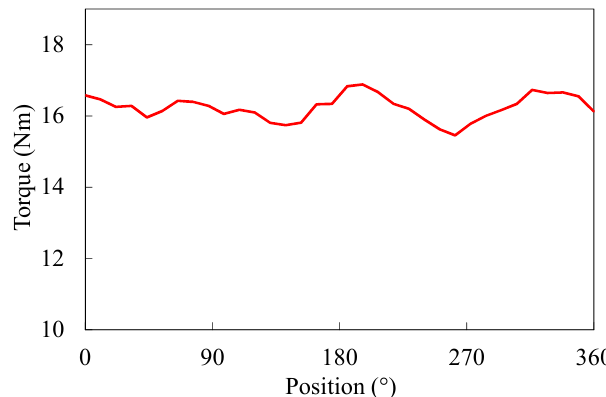
Figure 20. Torque of the proposed machine. Table 2. Torque density comparison of two machines.